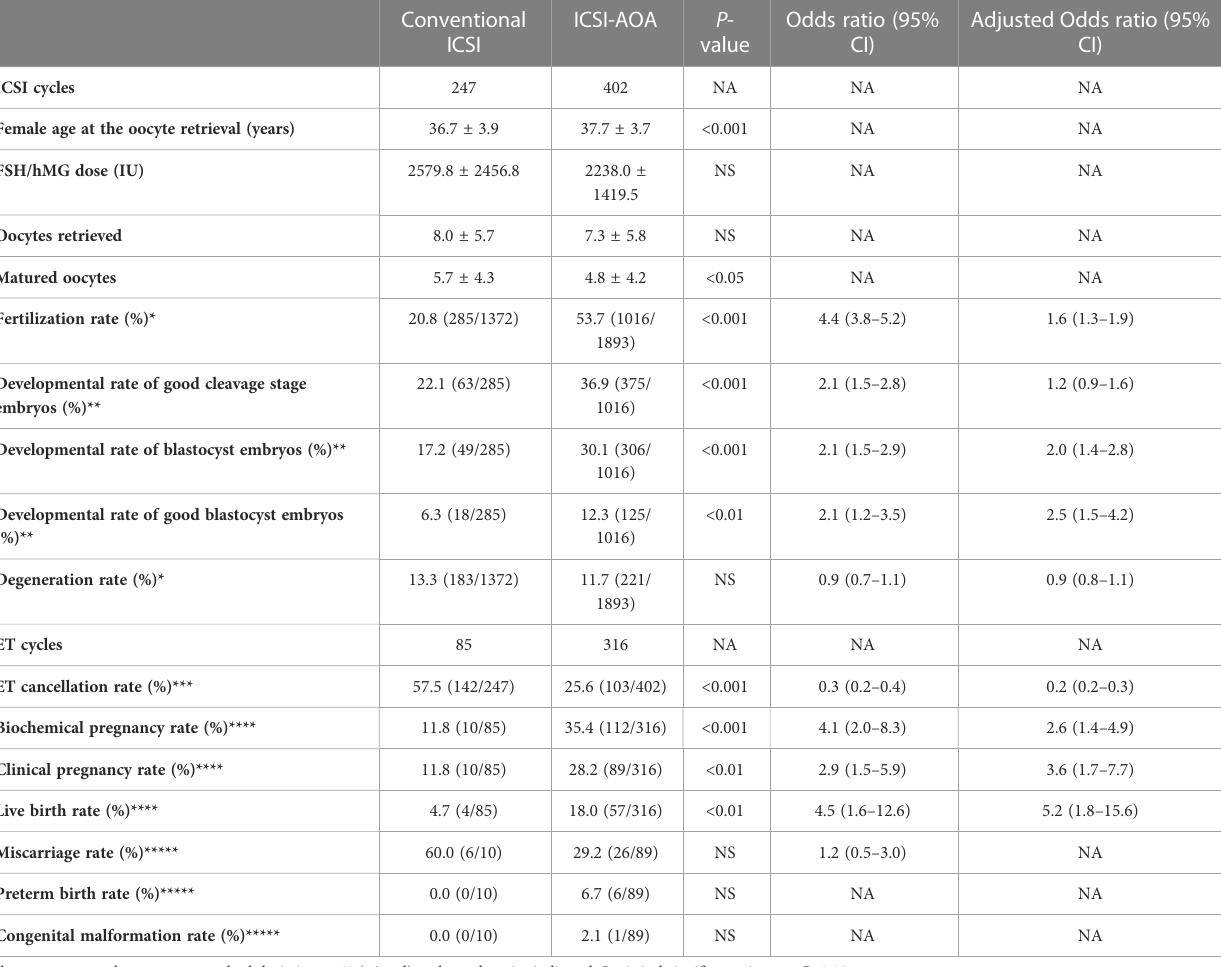
TABLE 1 Embryological and clinical outcomes after intracytoplasmic sperm injection (ICSI) and subsequent arti fi cial oocyte activation (AOA)